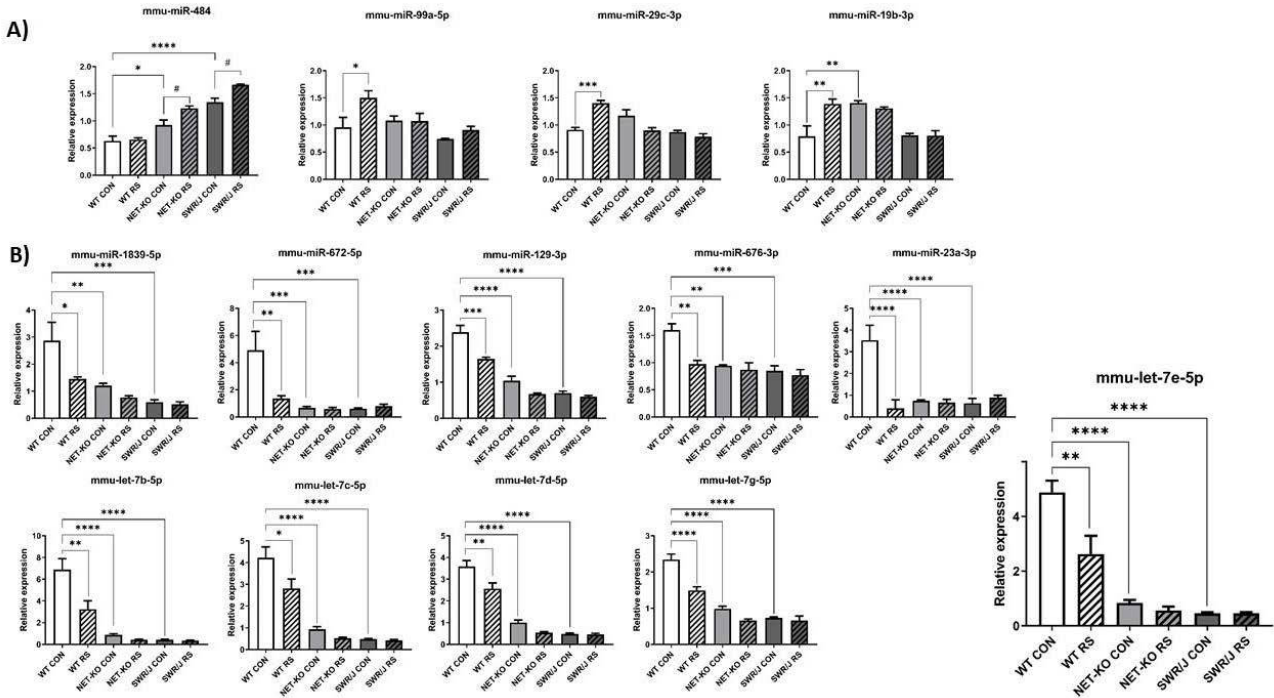
Figure 1. The expression of miRNAs in the prefrontal cortex (PFC) of three genotypes of mice following restraint stress (RS). ( A , B ) show the expression of miRNAs that were altered upon RS. WT—wild-type mice; NET-KO—norepinephrine transporter knock-out mice; SWR/J—Swiss mice. CON—control group; RS—restraint stress group. * p ≤ 0.05, ** p ≤ 0.01; *** p ≤ 0.001; **** p ≤ 0.0001; # p ≤ 0.05; n = 4.